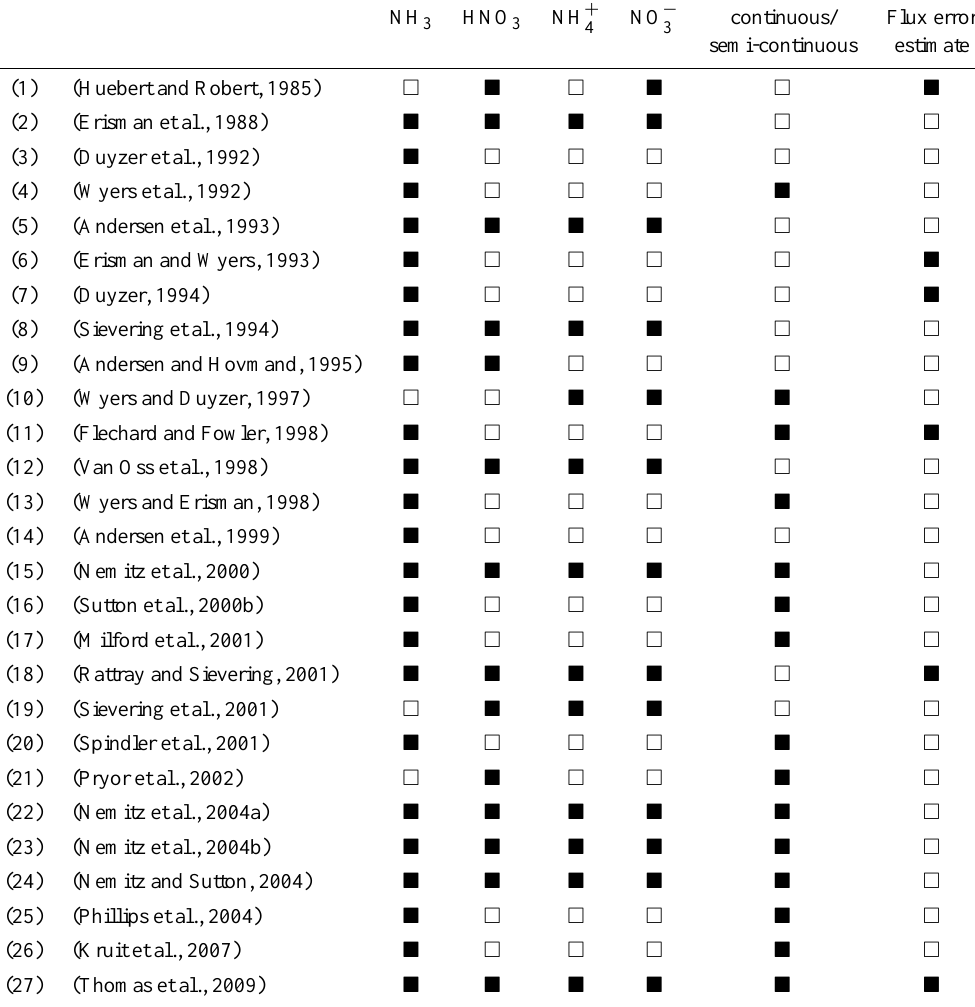
Table 6. List of studies that have performed aerodynamic gradient measurements of NH 3 , HNO 3 , particulate NH + measured species, whether or not the method was continuous or semi-continuous, and whether a precision (error) estimate was used to derive and discuss exchange